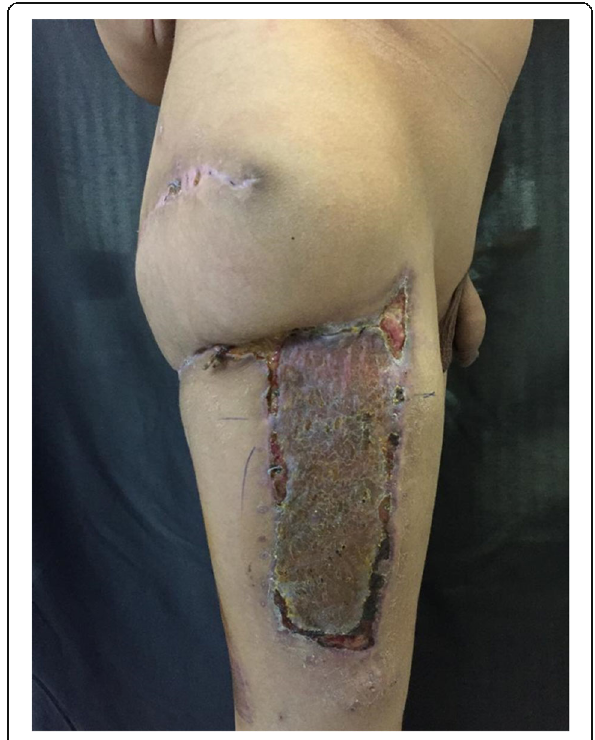
Fig. 9 Image of the patient after 14 days of recovery. Right thigh